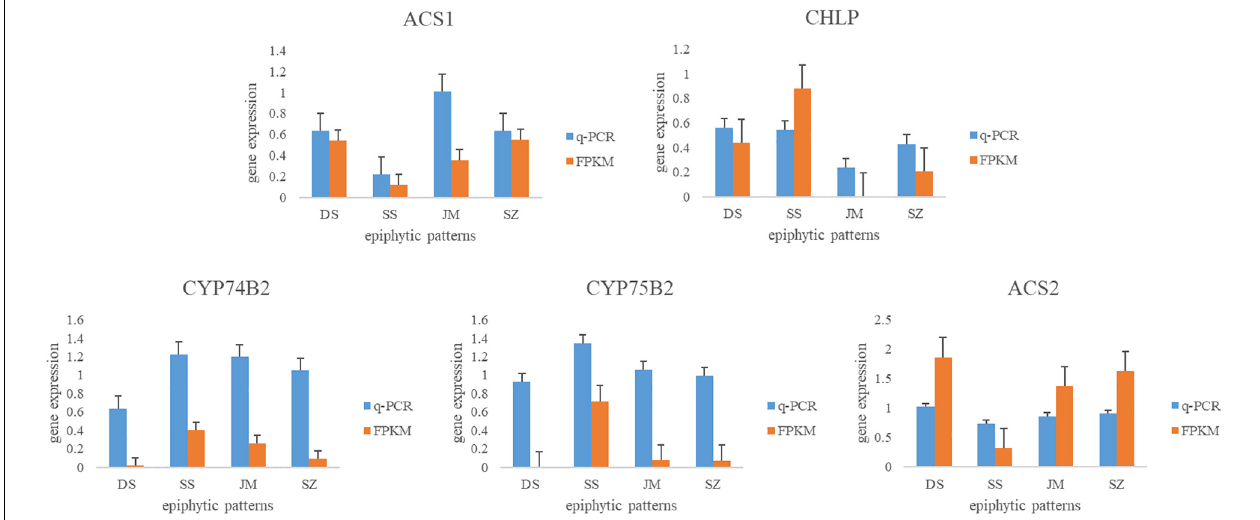
FIGURE 8 | qRT-PCR analysis of differential genes in Dendrobium nobile . The ordinate corresponds to the average change of expression value, the abscissa represents four different epiphytic patterns, and the FPKM represents the value of transcriptome